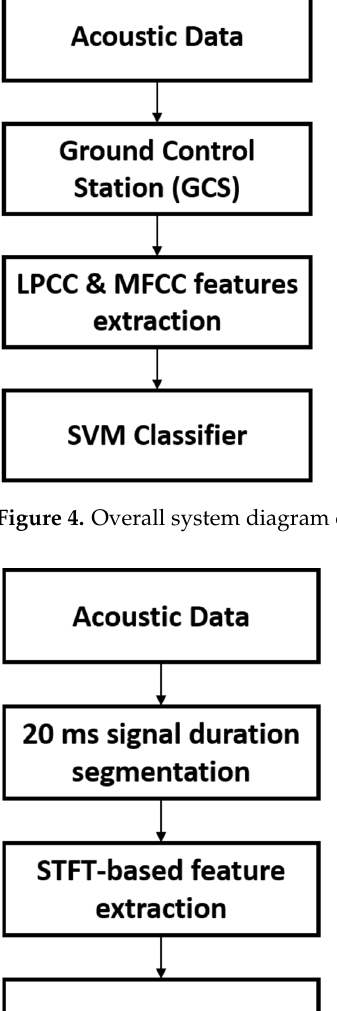
Figure 5. System overview of the method introduced in [39] .